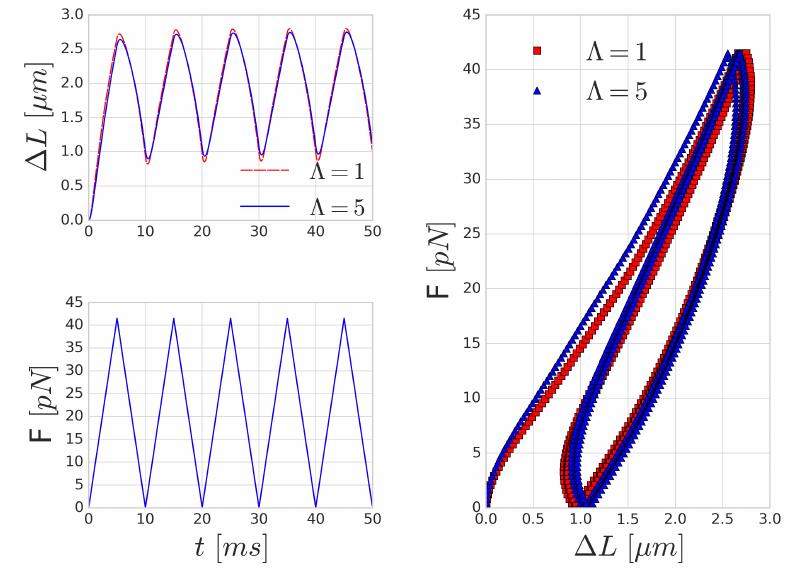
Figure 6. Stretching results with a period of 10 ms: ( Top left ) The elongation of the longest axis of the RBC ( ∆ L ) over time. ( Bottom left ) The magnitude of the force applied on opposing membrane areas over time. ( Right ) The applied force magnitude versus the corresponding elongation of the